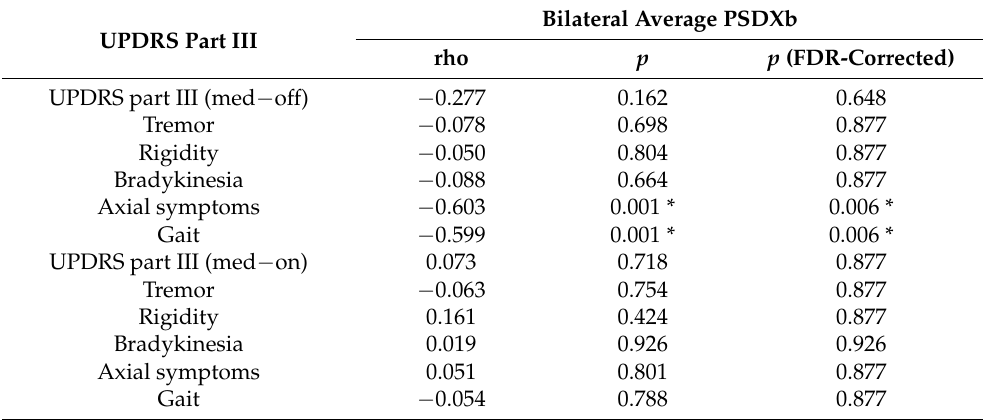
Table 3. Results of the correlation analysis between the bilateral average PSDXb and UPDRS part